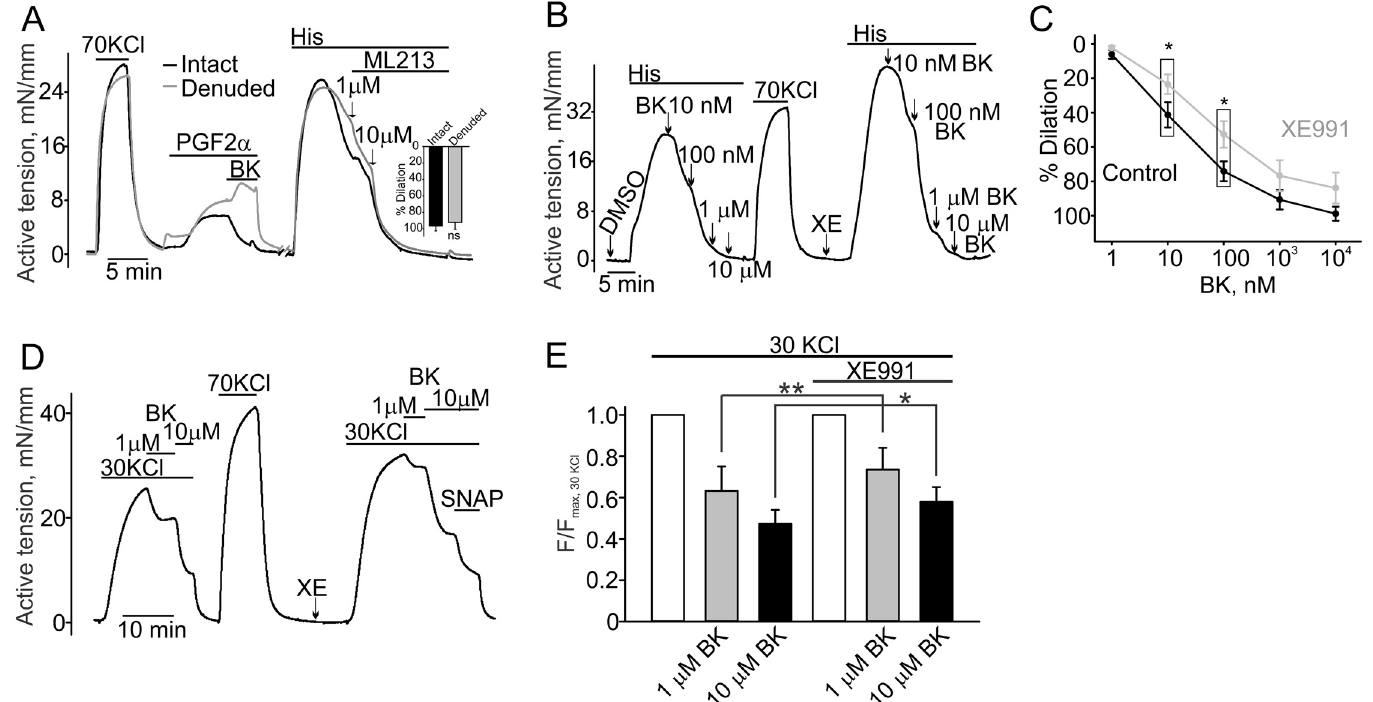
Fig 4. Functional role of K v 7 channels in the endothelium. A, Sample isometric tension measurement traces obtained in intact (black trace) and denuded (grey trace) domestic pig CA rings are shown. The insert shows that both intact and endothelium-denuded CA rings were equally dilated by ML213 (10 μ M, n = 3). PGF 2 α stands for Prostaglandin F 2 α (10 μ M). B, A sample trace illustrating that the bradykinin-induced dilation is reduced in the presence of XE991 (10 μ M) in a histamine-pre-contracted CA ring (10 nM bradykinin: 41.3 ± 7.3% for DMSO vs. 23.5 ± 5.73% for XE991; 100 nM bradykinin: 74.1 ± 5. 8% for DMSO vs. 52.7 ± 7.7% for XE991, n = 8). C , The concentration-response curves for bradykinin-induced dilations of histamine-pre-contracted rings obtained in the presence or absence of XE991 (10 μ M). D , A sample trace illustrating the effect of XE991 (10 μ M) on bradykinin-induced dilations in a 30 mM KCl-pre- contracted RCA ring. XE991 reduced bradykinin-induced relaxations. E , The summary for the data shown in the panel D. BK stands for bradykinin. Coronary artery rings were treated with 1 μ M BK (n = 6) and 10 μ M BK (n = 7).